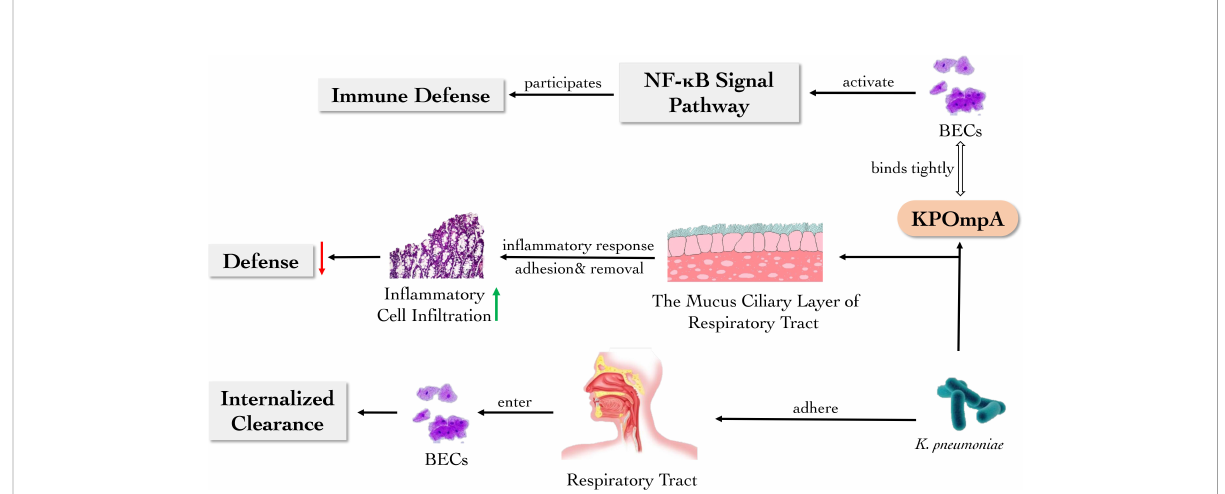
FIGURE 1 The main role of respiratory barriers against K. pneumoniae. K. pneumoniae can be eliminated by BECs and the mucus cilia layer of the respiratory tract. KPOmpA from K. pneumoniae binds tightly to BECs, thereby activating NF- k B signal pathway to participate in the host defense. However, K. pneumoniae and its products cause airway in fl ammation and weaken airway